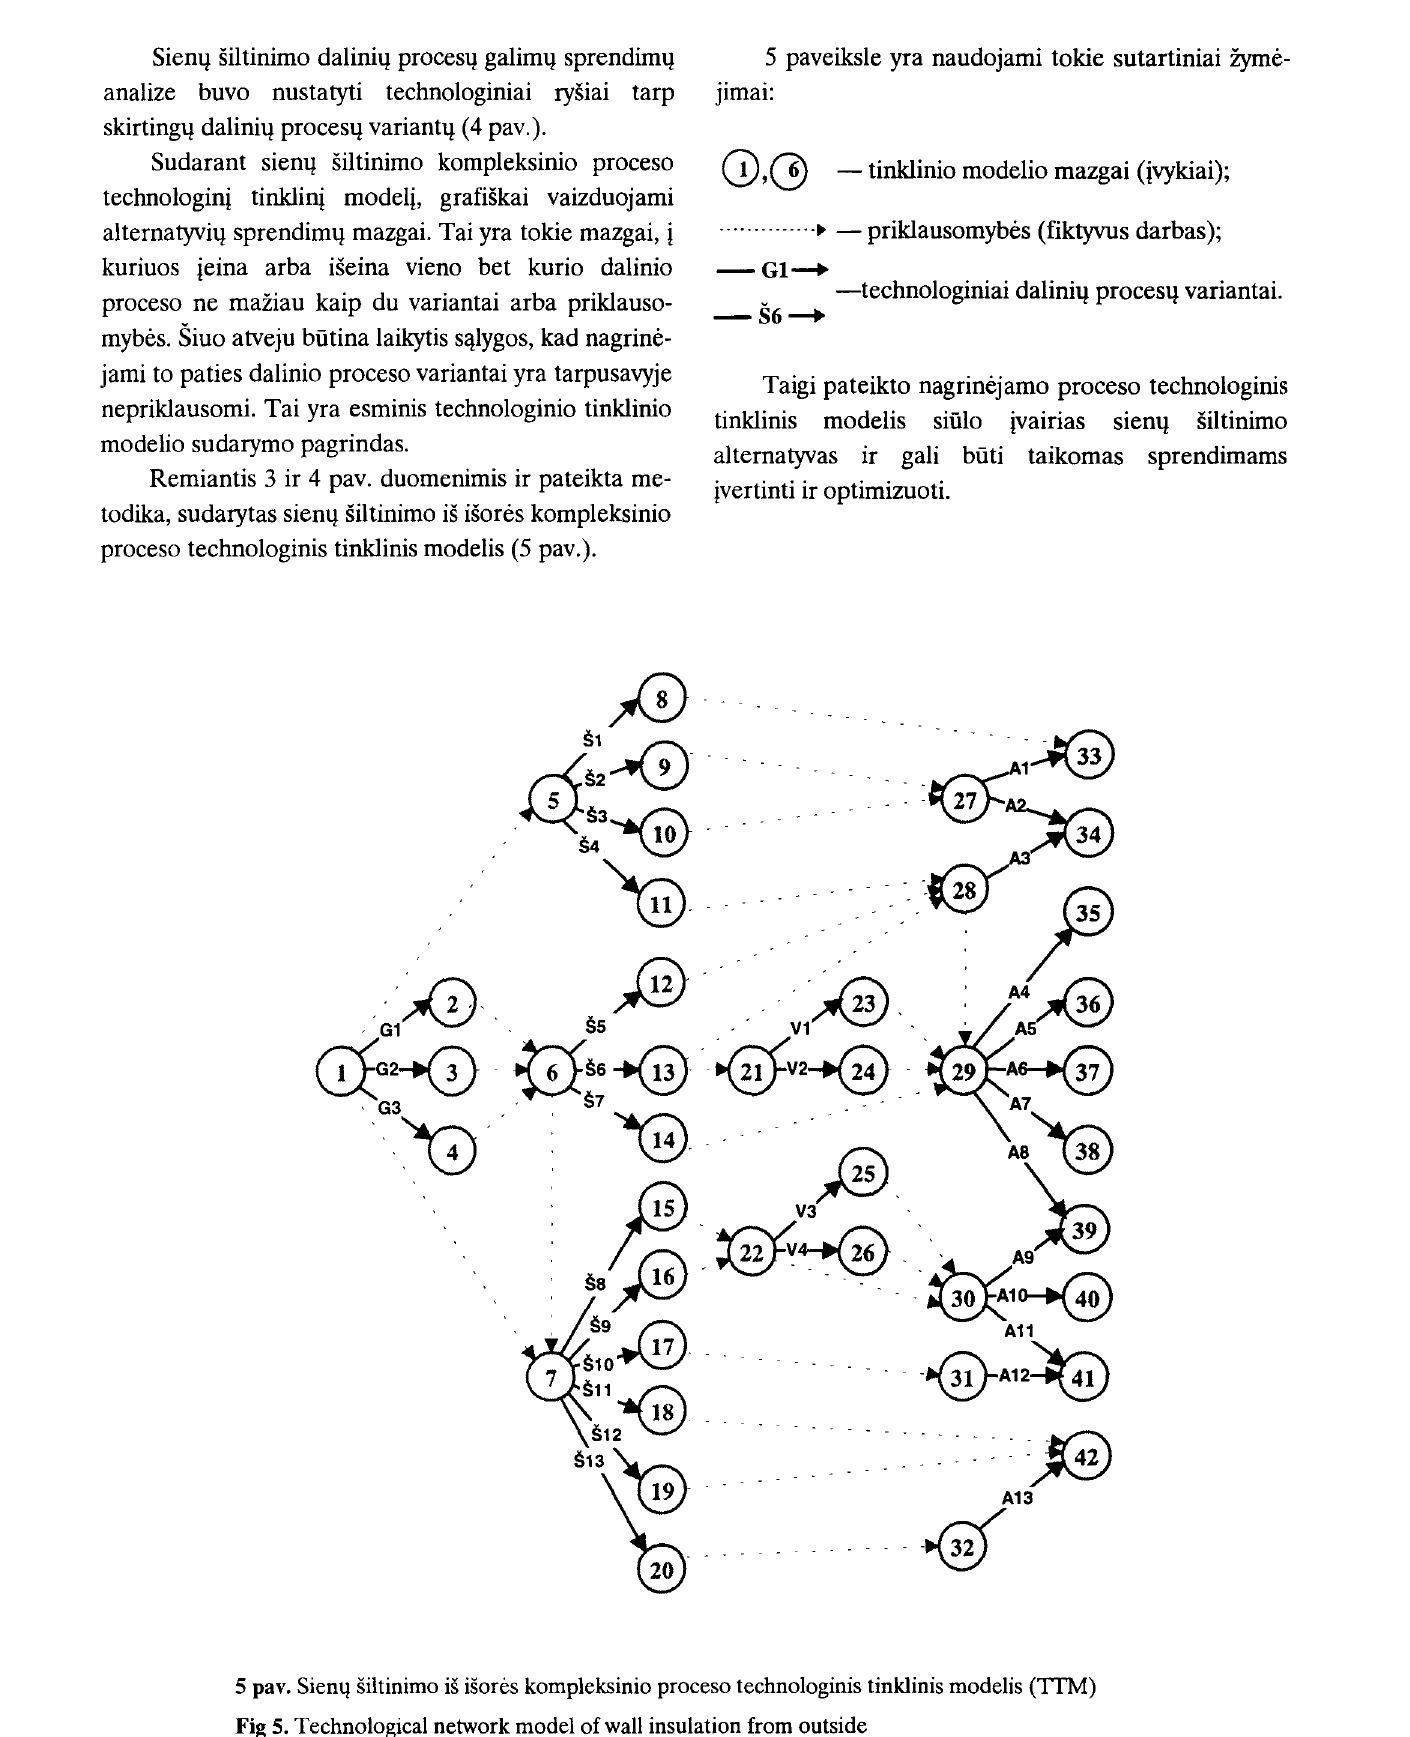
Fig 5. Technological network model of wall insulation from